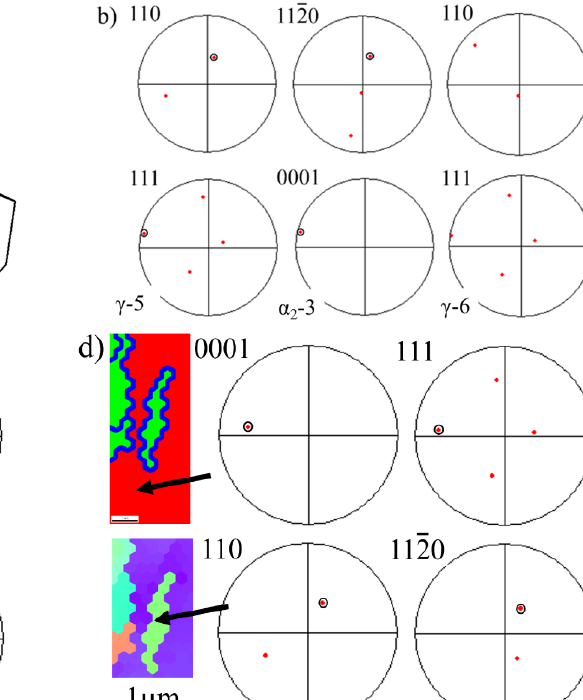
Figure 5. Misorientation measured along ( a ) L1 line and ( b ) H1 line in Figure 4b.